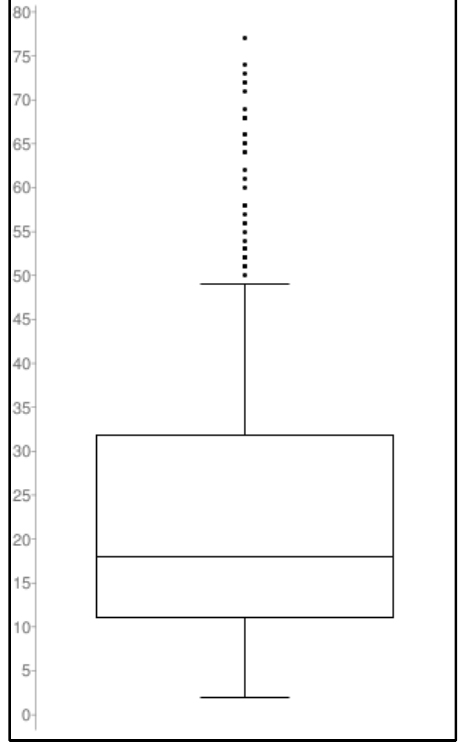
Figure 6. Box plot showing the spread of the DBV concentration measured in 520 patients’ plasma microsamples. Population size: 520; Median: 18; Minimum: 2.0; Maximum: 77.0; First quartile: 11; Third quartile: 31.8; Interquartile Range: 20.8.